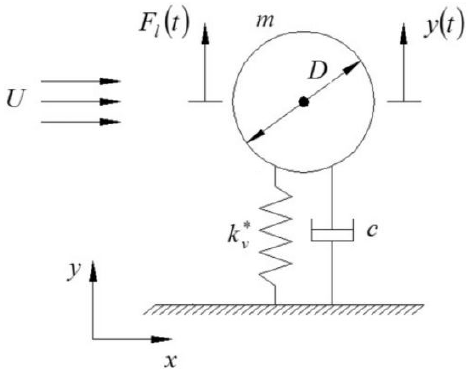
Figure 1. Schematic diagram of the elastically mounted circular cylinder with